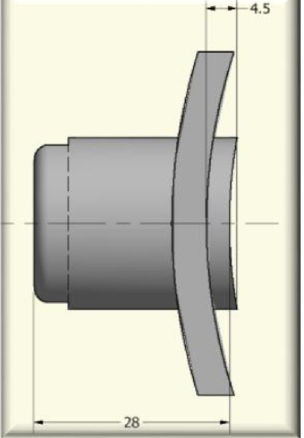
Fig. 10. Modeling with Autodesk Inventor